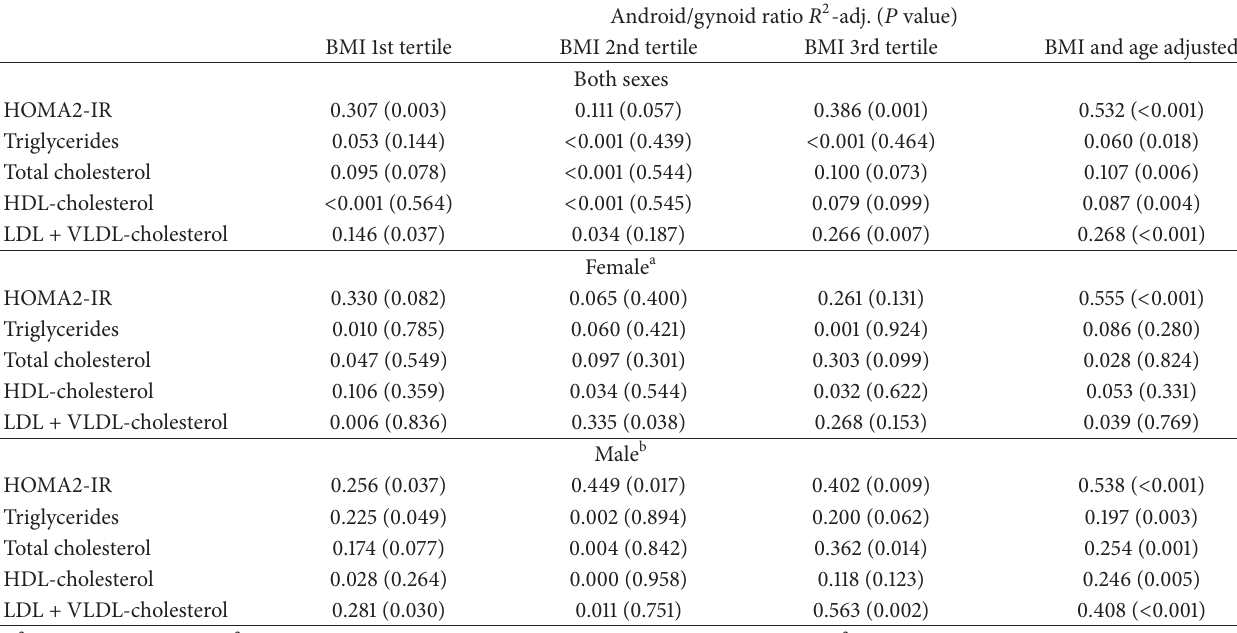
Table 4: Regression based correlation analyses adjusted 𝑅 2 between android/gynoid ratio and our metabolic and cardiovascular risk factors. Regression models for each BMI tertile as well as a BMI tertile and age adjusted regression